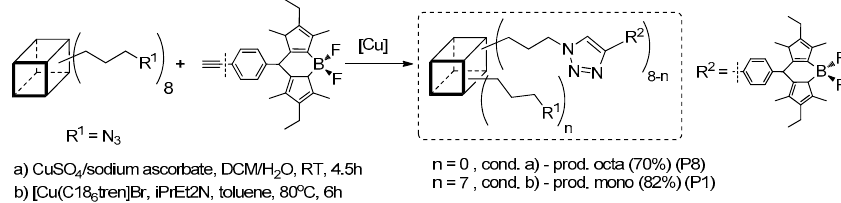
Figure 38. Reaction path towards octa- and mono-BDP derivatives of T 8 silsesquioxane (BDP–POSS).